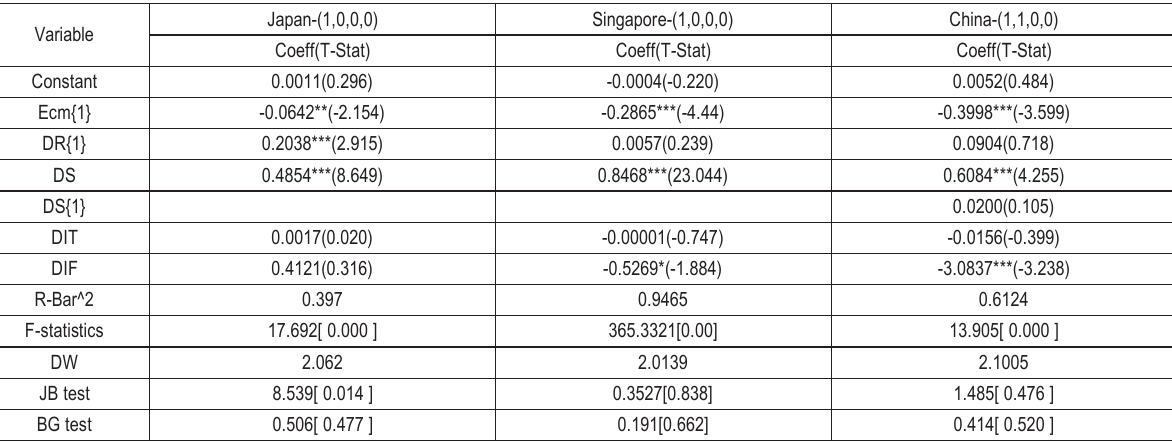
Table 5. The results of the error correction